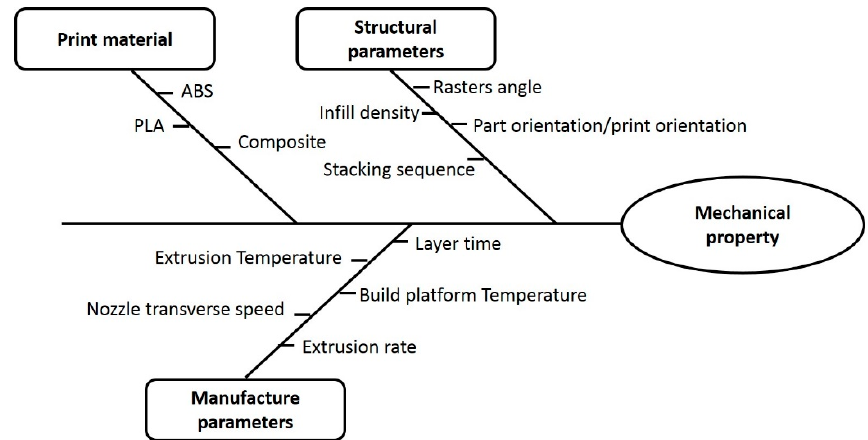
Figure 3. Ishikawa diagram showing the main parameters that have a role on the resulting mechanical properties of FFF.